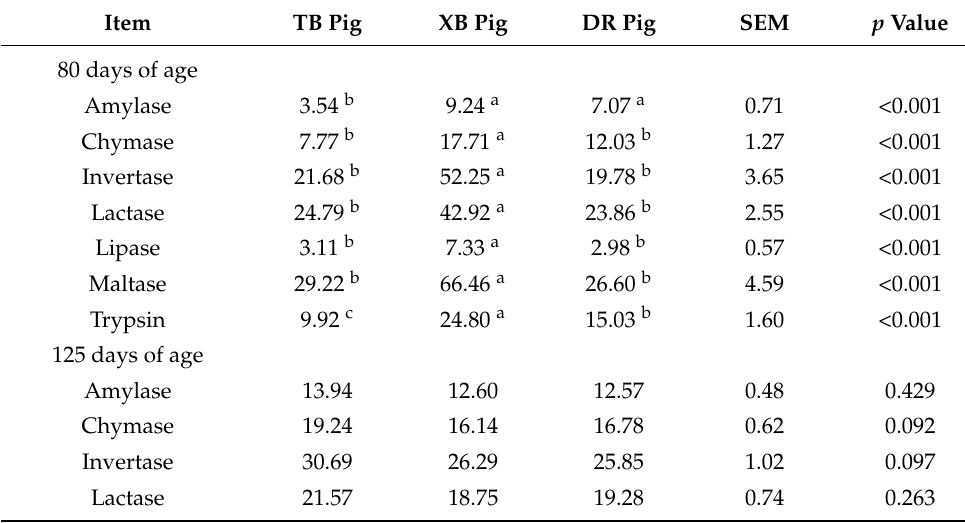
Table 11. Ileal digestive enzyme activities of three pig breeds at different ages (U/g).